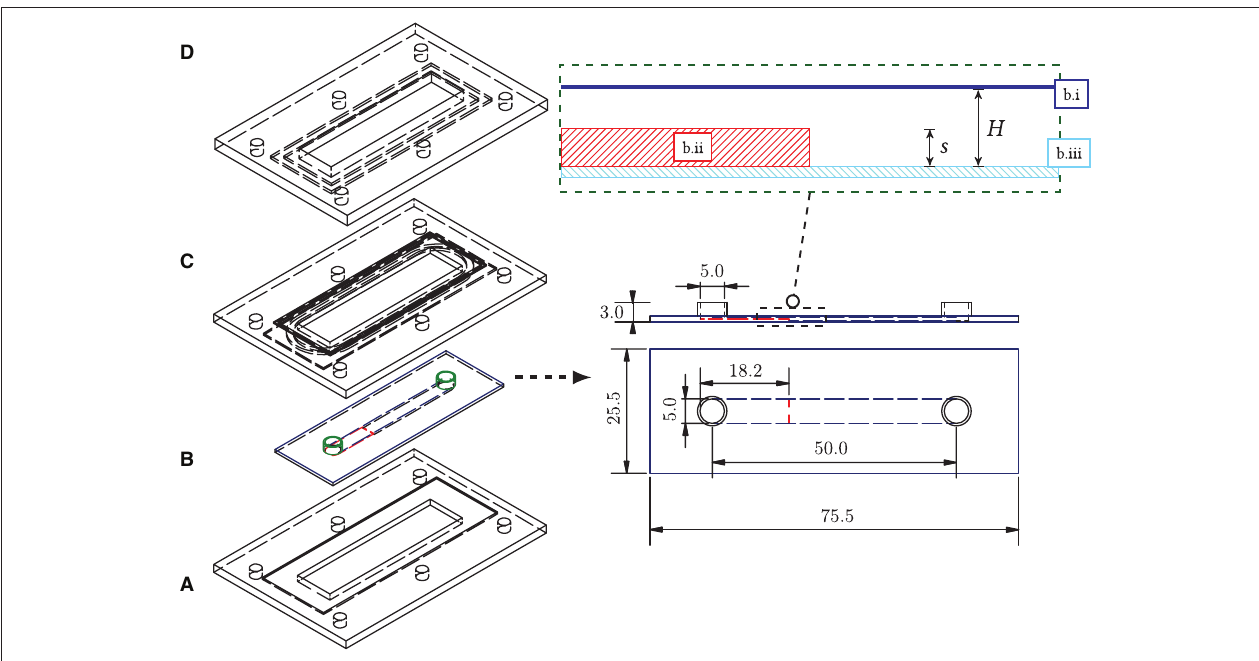
FIGURE 2 | (Left) Overall structure of the backward-facing step flow chamber and the seal frame. (A) Bottom frame with recess for bonding (aluminum, milled); (B) Flow chamber (b.i: bottomless flow chamber, “Sticky slide 0.8,” ibidi ; b.ii: step foil cutout, 400 µ m, Aslan ; b.iii: plastic cover glass, ibidi ); (C) 3d-printed frame inlet with O-ring groove (ABS-like plastic “tough resin,” Formlabs ); (D) Upper frame with countersink and groove (aluminum, milled). All components are connected by six nuts and bolts. An O-ring (54 × 1.5 mm, acrylonitrile butadiene rubber) distributes the pressure from above to the flow chamber. The chamber (B) is glued into the bottom frame (A) to prevent buckling of the plastic cover glass of the chamber due to the system pressure. (Right) Structure of the flow chamber with backward-facing step, dimensions in mm. Top: horizontal profile of the chamber assembly: the bottomless chamber (dark-blue) is glued into the cover glass slide (light-blue) with the step attached to it